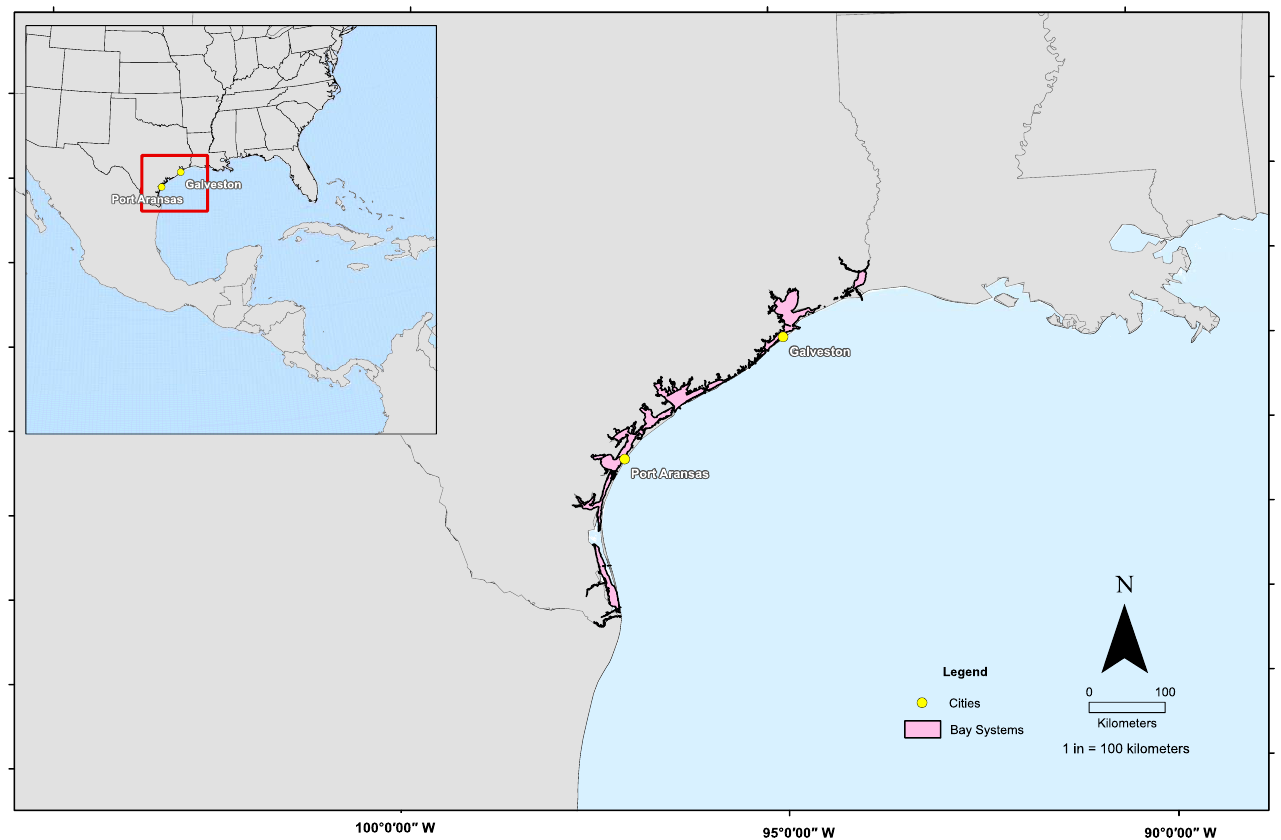
Figure 1. Study locations in the northwest Gulf of Mexico. Map of locations where sheepshead were caught on nearshore structures in Galveston and Port Aransas, TX, are